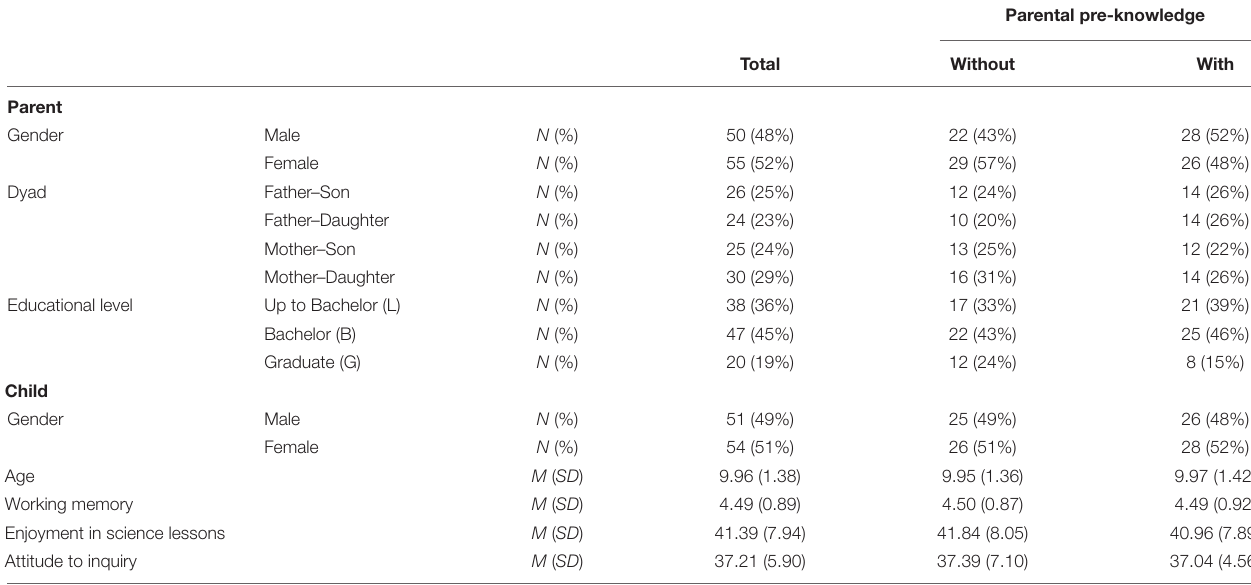
TABLE 1 | Factors and covariates, describing person characteristics of parent and child.